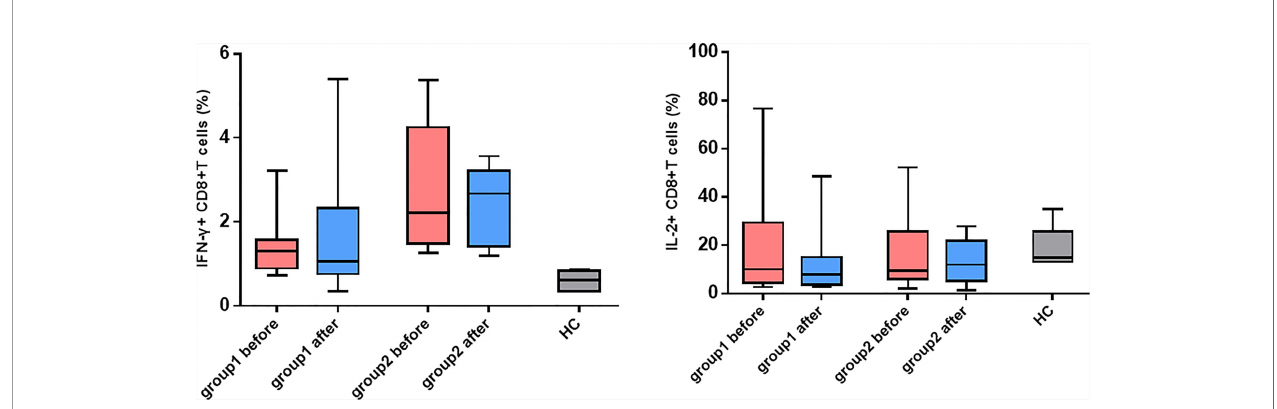
FIGURE 5 | |The changes in IFN- g and IL-2 expressed CD8 + T cells. Expression of IFN- g and IL-2 on CD8 + T cells before and after childbirth between the group 1 and